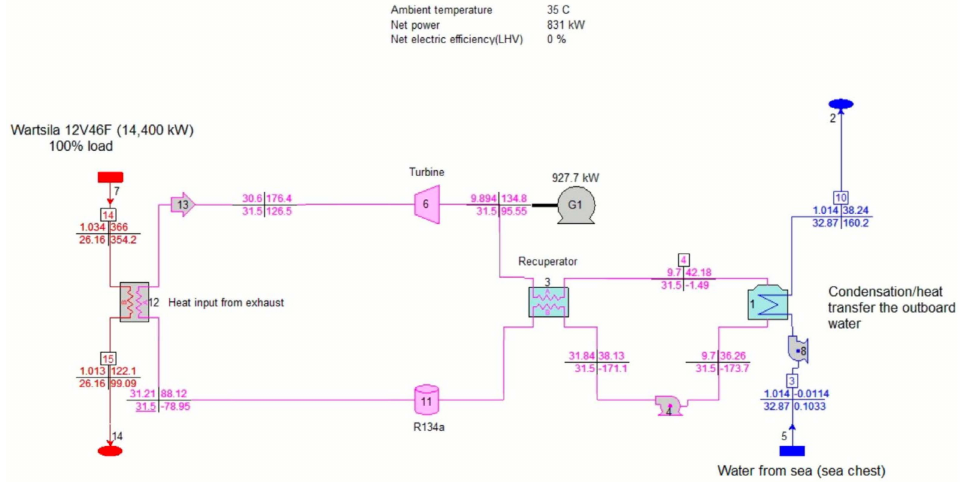
Figure 2. Single stage pressure organic Rankine cycle with recuperator: 1 = condenser; 2 = outboard; 3 = heat exchanger (recuperator); 4 = working fluid pump; 5 = sea chest inlet; 6 = turbine; 7 = exhaust gas inlet; 8 = sea water pump; 11 = working fluid tank; 14 =